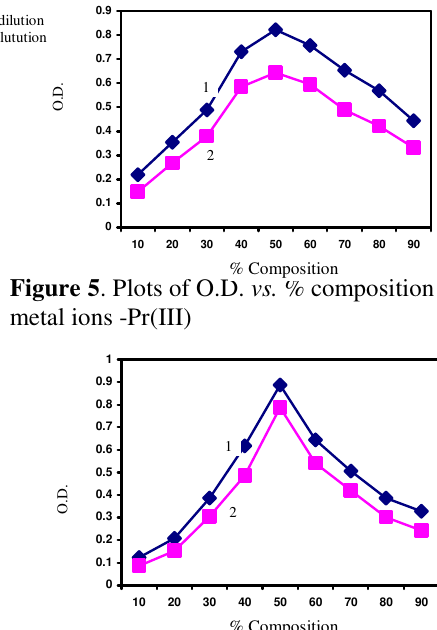
Figure 7. Plots of O.D. vs. % composition of metal ions